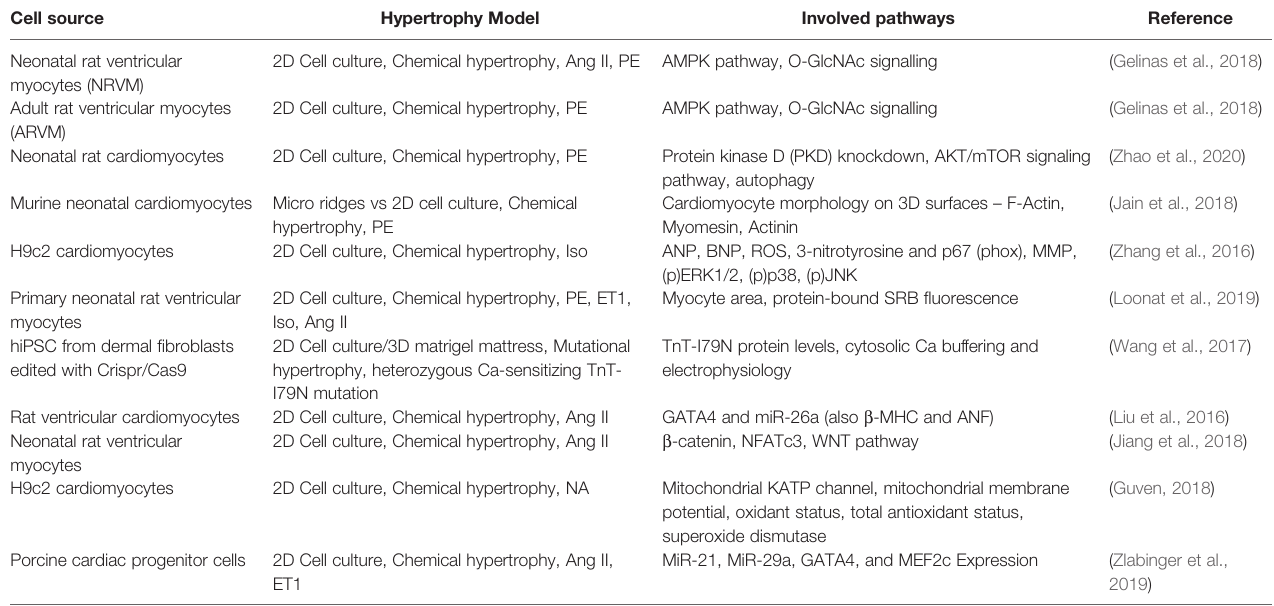
TABLE 1 | Overview over different approaches of hypertrophy induction methods and used cell sources in in vitro models and the investigated pathway of the study. Cell